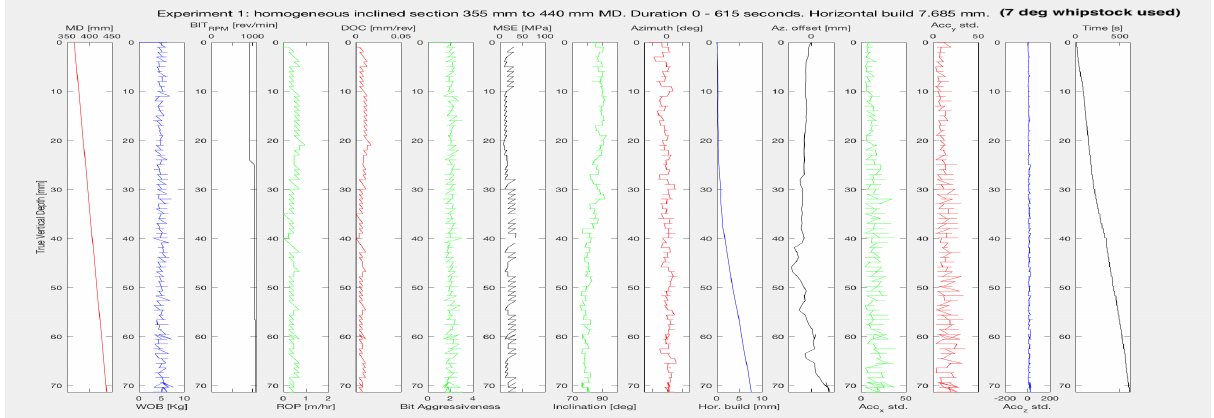
Figure 5: Experiment 1: Well log representing rig performance when drilling with downhole motor in inclined section using a 7 degrees whipstock.